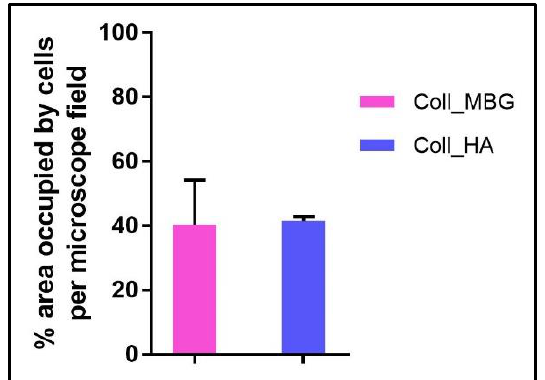
Figure 19. Diagram of the quantification of the area occupied by osteoblasts seeded on the collagen- based scaffolds with nano-hydroxyapatite (Coll_HA) and collagen-based scaffolds containing mes- oporous bioactive glasses (Coll_MBG) and stained with the live-dead assay at 7 days.